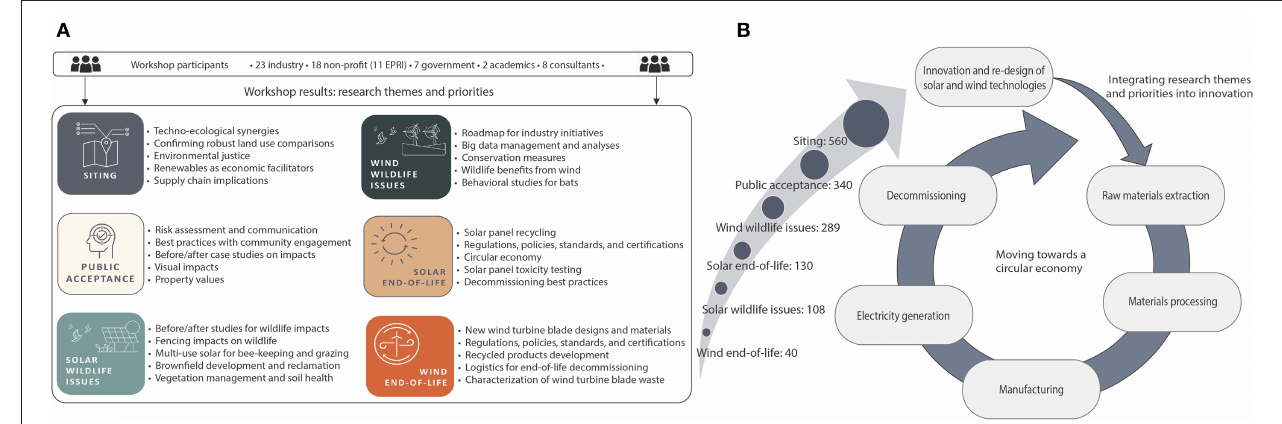
FIGURE 5 | (A,B) Integration of research themes into innovation across the life cycle of wind and solar technologies. (A) Summarizes the results from the 58-expert stakeholder workshop developed using brainstorming and prioritization exercises (see Supplementary Material for additional details about the research priorities). Fifty-eight experts attended, spanning representatives from government, industry and non-profits (seven, 23, and 15 experts, respectively) and two academics; eleven EPRI staff were also in attendance and categorized as non-profit attendees. The numbers reported in the figure represent the cumulative corpus of publications on each individual theme from Web of Science (2020). (B) Presents a circular economy approach to align United Nations Sustainable Development Goals (SDGs) with climate goals in a transition to the widespread diffusion of solar and wind technologies. Graphics use icons reproduced from the Noun Project (https://thenounproject. com).